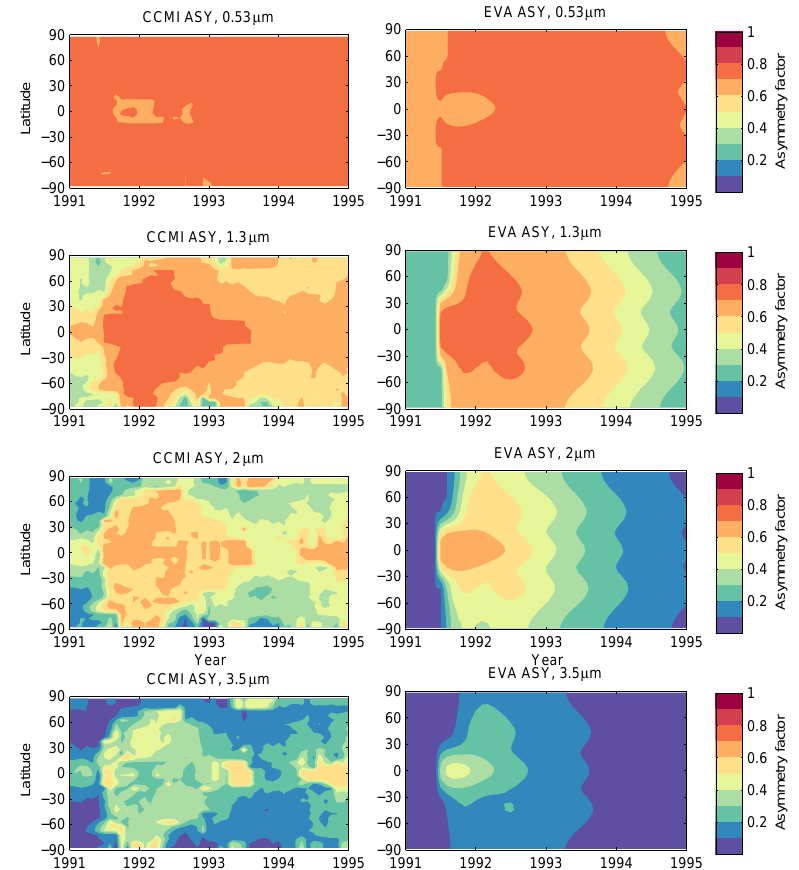
Figure 9. ASY after the Pinatubo eruption at 20km for selected wavelengths from (left) CCMI and (right) EVA.